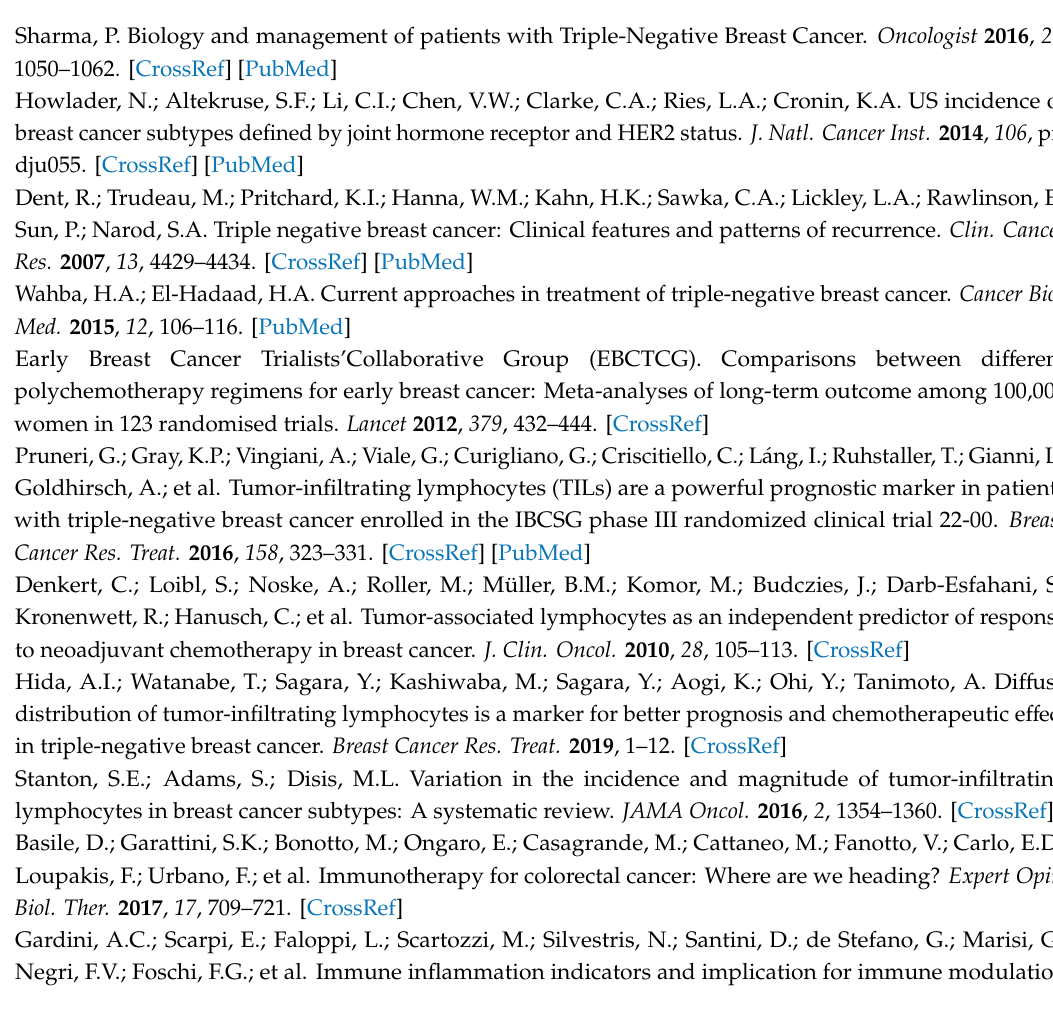
Table S1: Relationship between tumor markers and clinicopathological features; Table S2: Dilution, source, staining of antibodies and cut o ff used; Figure S1: Survival analysis. DFS curves for patients with simultaneously AR +/ FOXA1 + phenotype respect to all other tumors ( p = 0.0117); Figure S2: Survival analysis. DFS curves for patients with simultaneously AR − / FOXA1 + vs. AR +/ FOXA1 − ( p = 0.080). TILs − / BRCA1 + vs. to TILs +/ BRCA1 − ( p = 0.097) and TILs +/ PD-L1 + Vs TILs − / PD-L1 − ( p = 0.100)